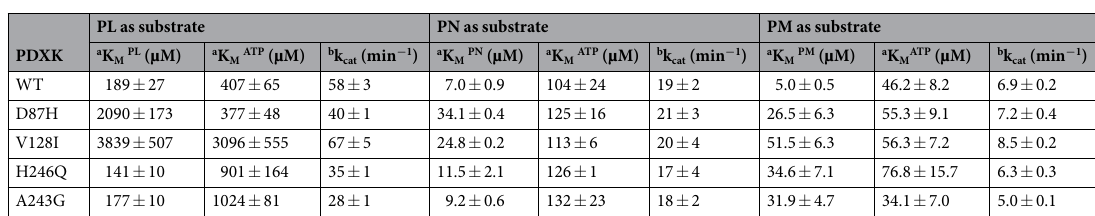
Table 1. Kinetic parameters of PDXK variant enzyme forms. All values are the average ± standard deviation of at least three independent determinations. a Determined varying the concentration of the related substrate, while keeping the other fixed and saturating. b Determined with ATP as fixed, saturating substrate. Values of k cat determined with the vitamer as fixed, saturating substrate were very similar and are not reported for